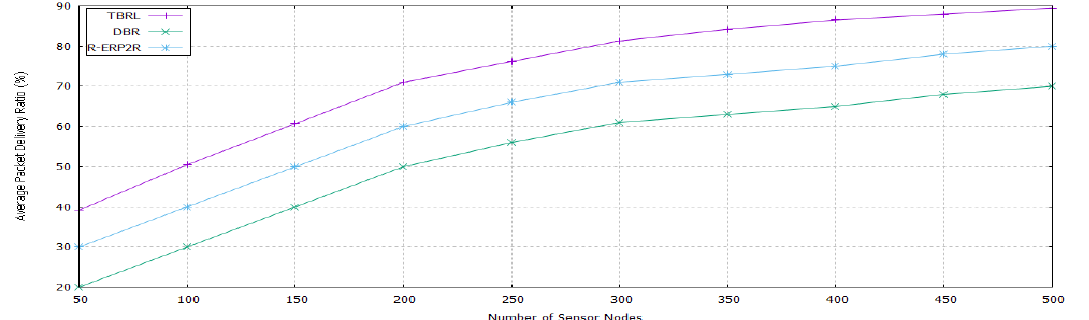
Figure 14. Packet Delivery Ratio of TBRL, DBR and R-ER P 2